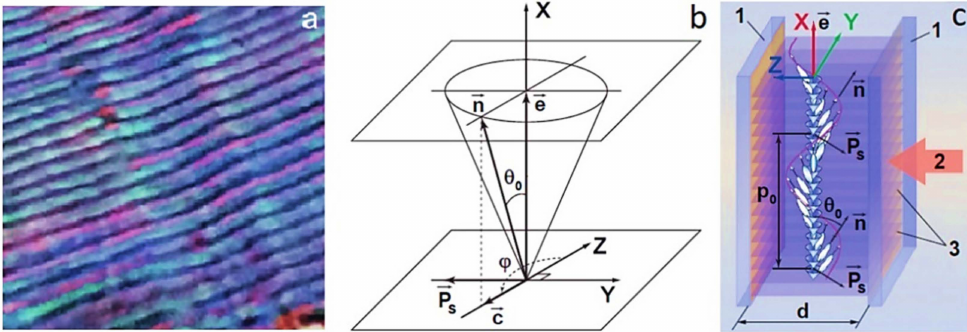
Figure 1. ( a ) An image of the HSFLC in a polarizing microscope, image size is 80 µ m × 80 µ m [19]; → n in a separate smectic layer, the plane of which is parallel to ( b ) the location of the HSFLC director → → → c is c-director, e is the normal to the smectic P s is the spontaneous polarization vector, YZ plane, layer plane, θ 0 is the molecular tilt angle in smectic layers, ϕ is azimuth angle of the director in the plane of the smectic layer [20]; ( c ) the structure of HSFLC bounded by flat transparent and conductive substrates 1. Arrow 2 shows the direction along the planes of the smectic layers 3, which coincides with the direction of light propagation. The thickness of the HSFLC is designated as d